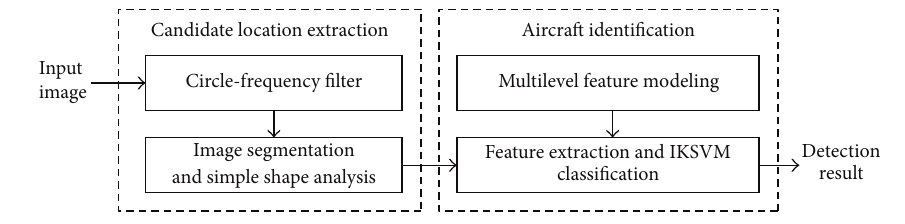
Figure 1: Flow diagram of the proposed method.